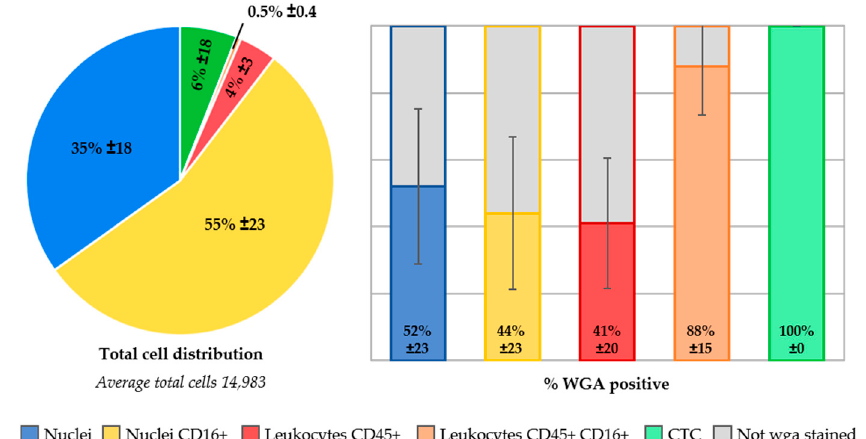
Figure 6. Distribution of cell populations in samples with wheat germ agglutinin (wga)-AlexaFluor488 staining ( n = 10). The stacked bar represents the five cell populations present in these cartridges. One healthy volunteer sample was spiked with MCF-7 cancer cells, which are represented in the “CTC” category (6%). Of each population, the percentage of cells that stained positive for wga is displayed on the right side of the image, whereas the population remaining unstained with wga is visualized in grey.